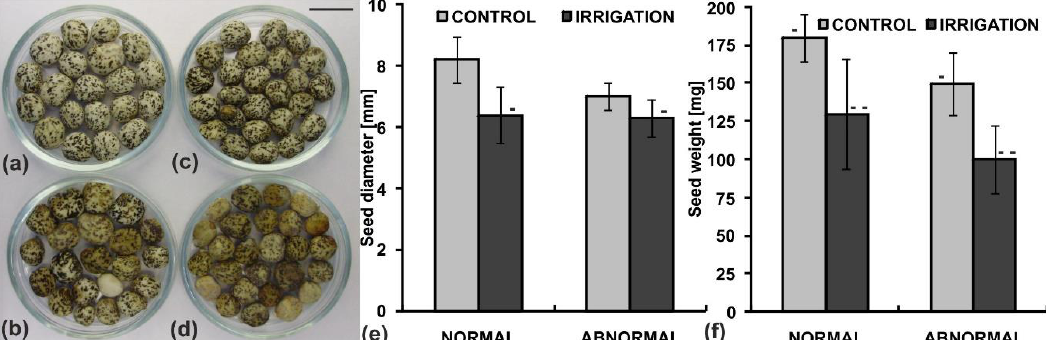
Figure 1. Seeds of yellow lupine collected from the control (not irrigated) and irrigated plants and sorted according to morphological features: ( a ) control—normal seeds, ( b ) control—abnormal seeds, ( c ) irrigated plants—normal seeds, ( d ) irrigated plants—abnormal seeds. Scale bar 10 mm, ( e ) seed size (diameter) measured along the long axis, ( f ) seed weight. Statistical significance between mean values of seed diameters and seed weights was assessed with the Mann–Whitney U test (p < 0.01) and Student’s t test ( p < 0.01), respectively. Error bars represent standard deviation (SD). Minuses and double minuses indicate pairs of statistically insignificant